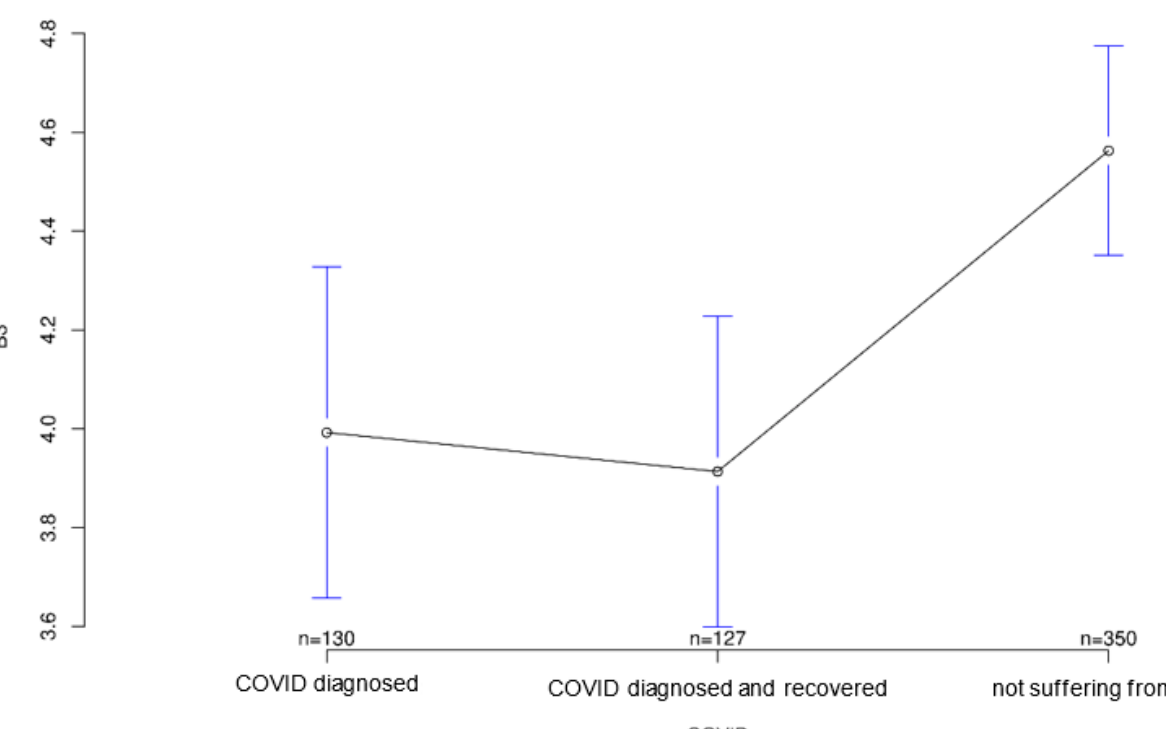
Figure 5. Average agreement with statement 3 of the COVID-specific questionnaire: “Body-worn sensor technology would always remind me of illness and thus would certainly be a psychological burden.” The y -axis shows the mean result of participants choice on the Likert